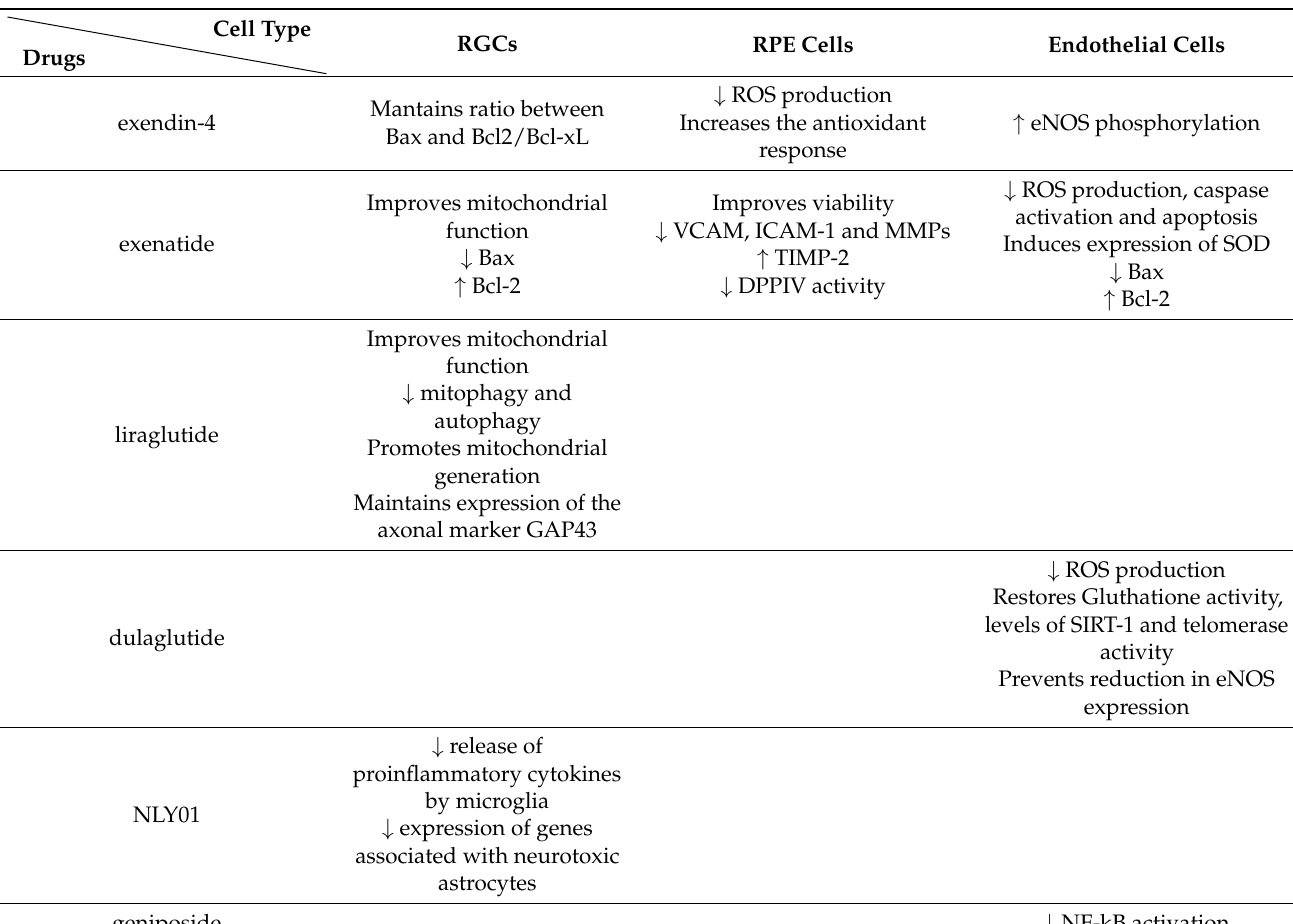
Table 2. Effects of GLP-1R activation in the retinal cells injured by inflammation, oxidative stress and high